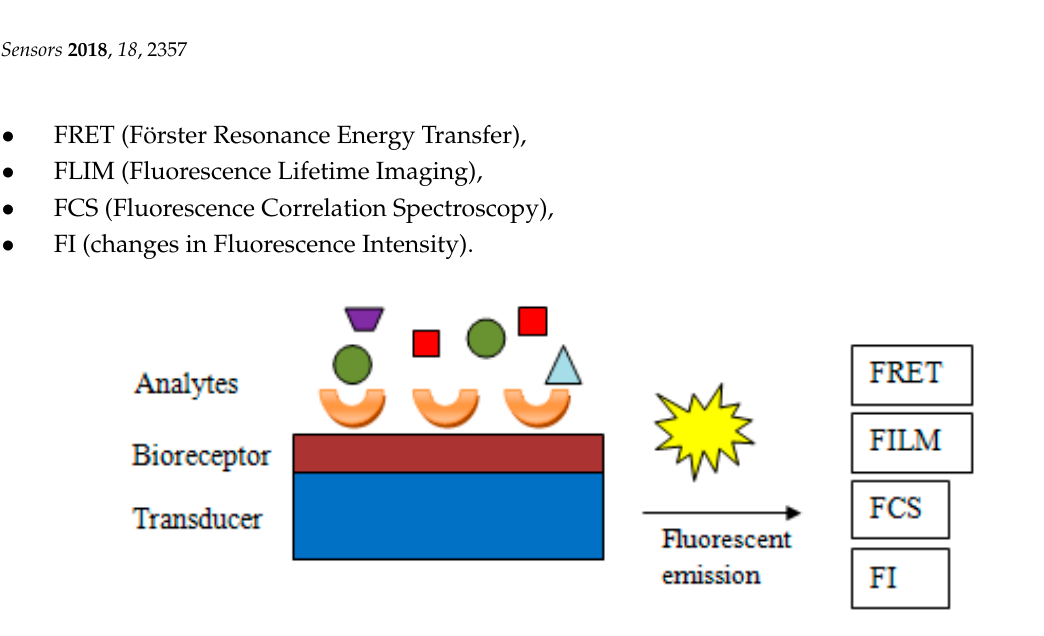
Figure 2. Methods for fluorescence determination using biosensors (general scheme).